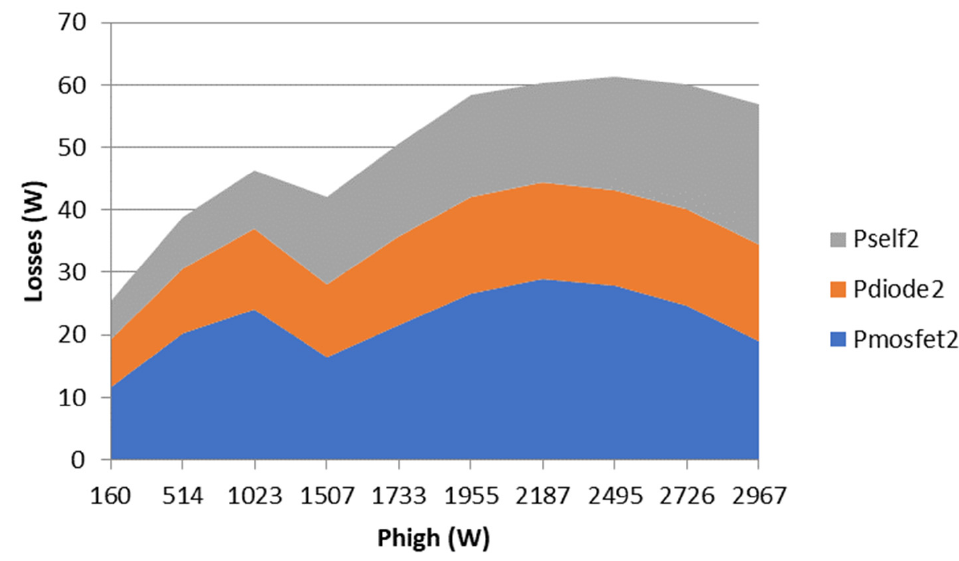
Figure 11. Repartition of the losses inside the phase #2 of the 3-Phase IBC prototype: the semicon- ductors losses are thermally measured and phase inductor losses electrically measured.